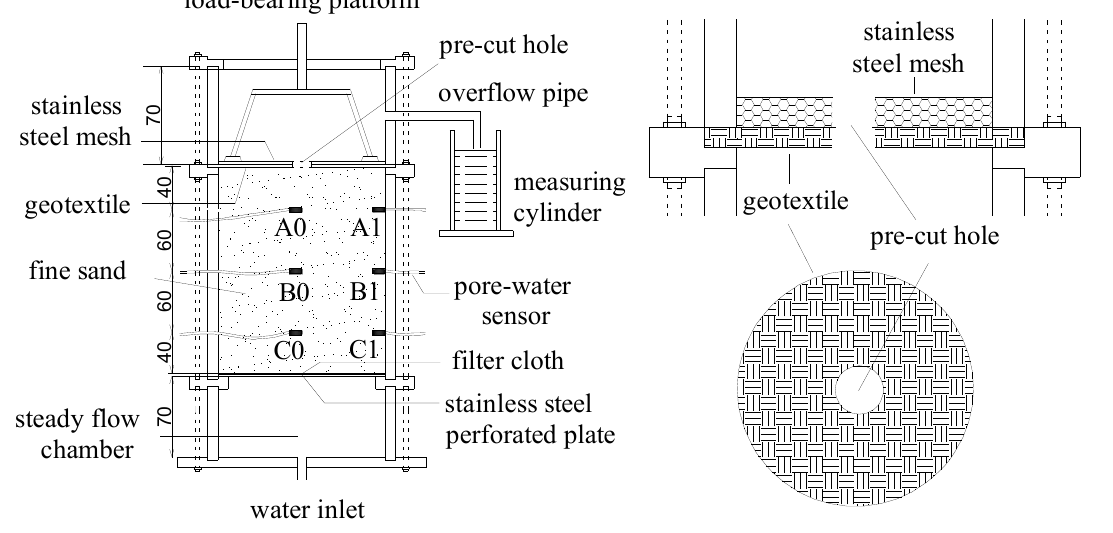
Figure 5. Schematic illustration of testing apparatus.